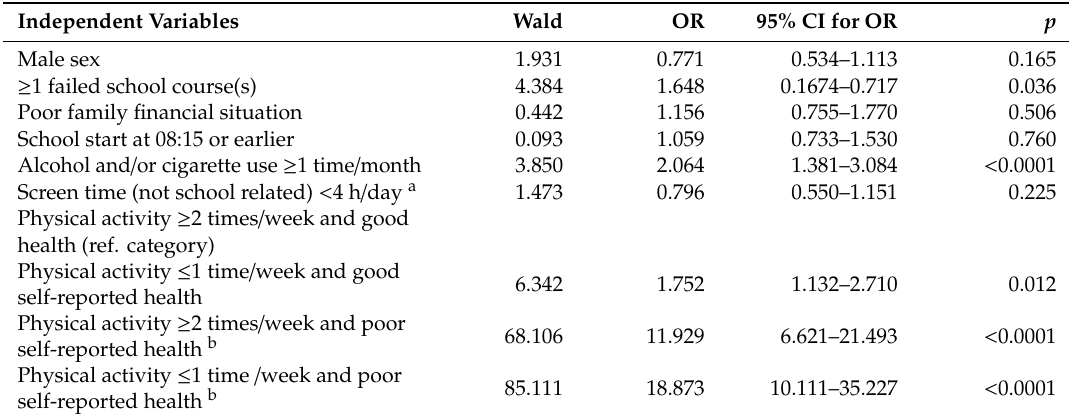
Table 3. Multiple logistic regression analysis of combined e ff ects of factors associated with insomnia (MISS ≥ 6) among adolescents aged 15–17 years (n =